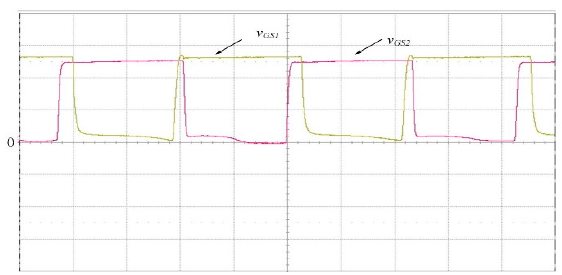
Figure 7. Voltage waveforms of v DS1 and v DS2 . ( v DS1 , v DS12 : 5 V/div, time: 5 μ s/div)